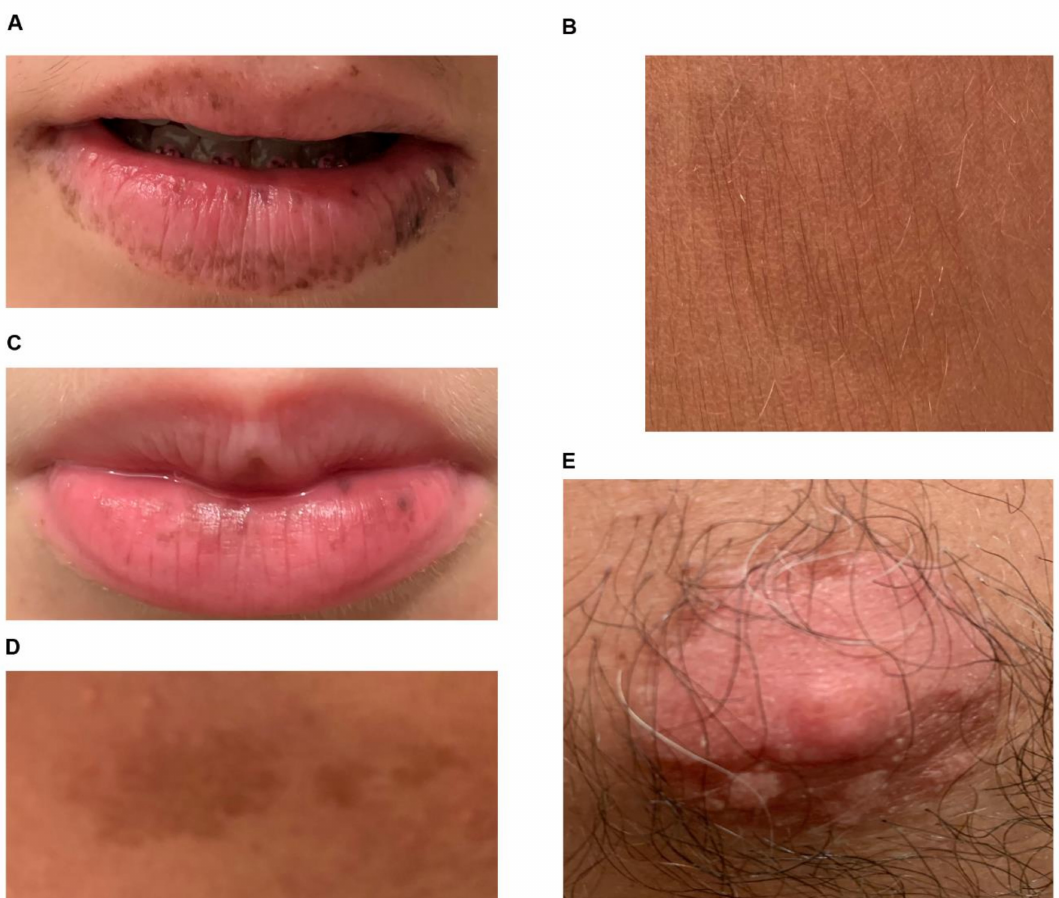
Figure 1. Caf é au lait spots of probands. ( A ) mucosal scattered black spots and typical caf é au lait spots on the lips of proband II-1; ( B ) caf é au lait cutaneous macules on the proband II-1 leg; ( C ) mucosal scattered black spots and typical caf é au lait spots on the lips of proband II-2; ( D ) caf é au lait cutaneous macules on the proband II-2 arm; ( E ) caf é au lait macules of the nipple areola of the probands’ father (subject